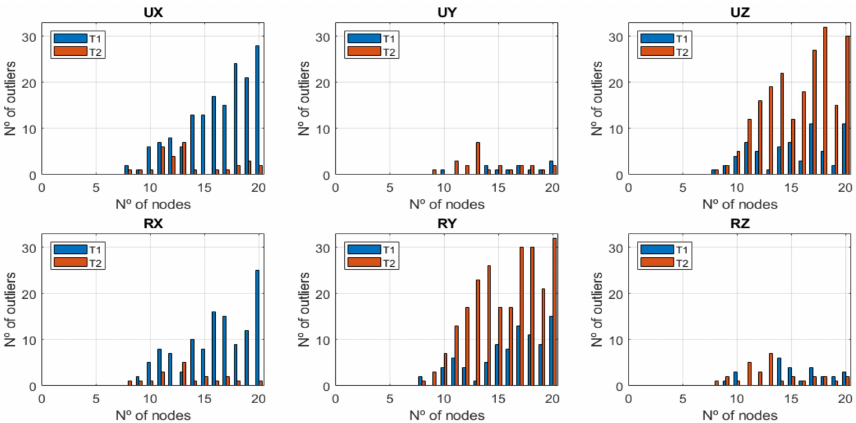
Figure 9. Outlier networks with respect to the number of